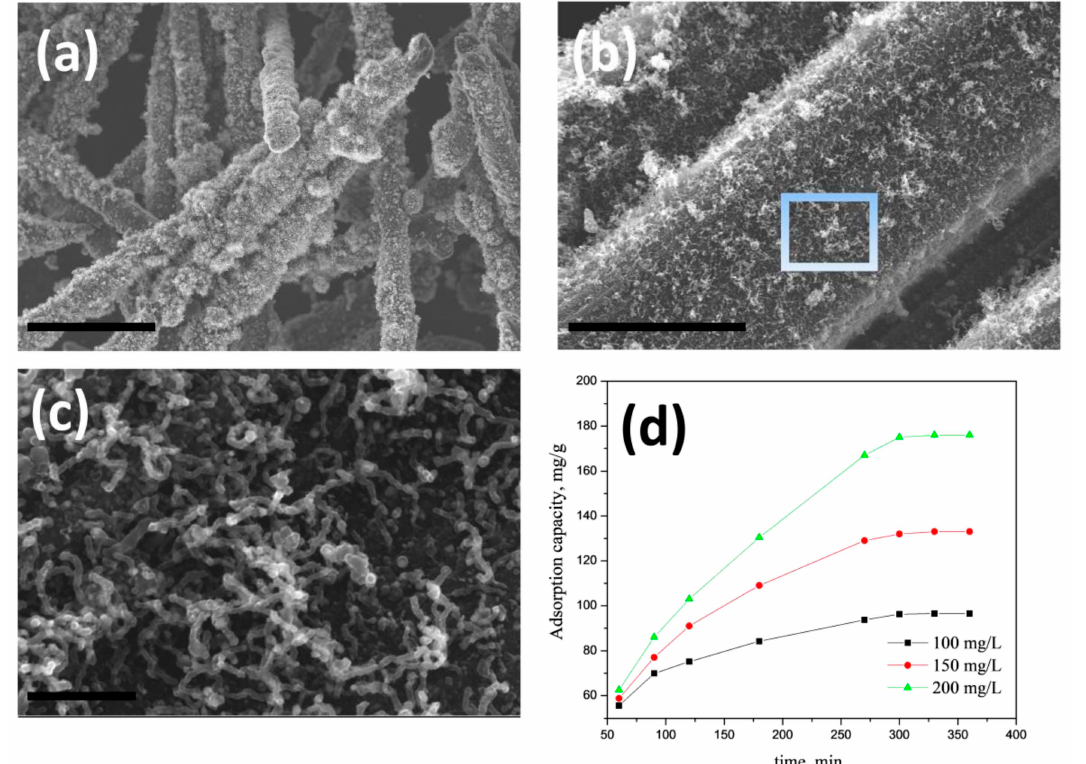
Figure 5. Representative SEM micrographs of MnO 2 @CNT-CF hybrid synthesized by using novel Mn-H 3 BTC precursors at low ( a ) and high ( b ) magnifications; ( c ) is the high-resolution image of the portion highlighted as rectangle in ( b ); scale bars are 30 µm ( a ); 3 µm ( b ) and 500 nm ( c ); Adsorption isotherms of arsenic on MnO 2 @CNT-CF nanostructures at various concentrations ( d ).